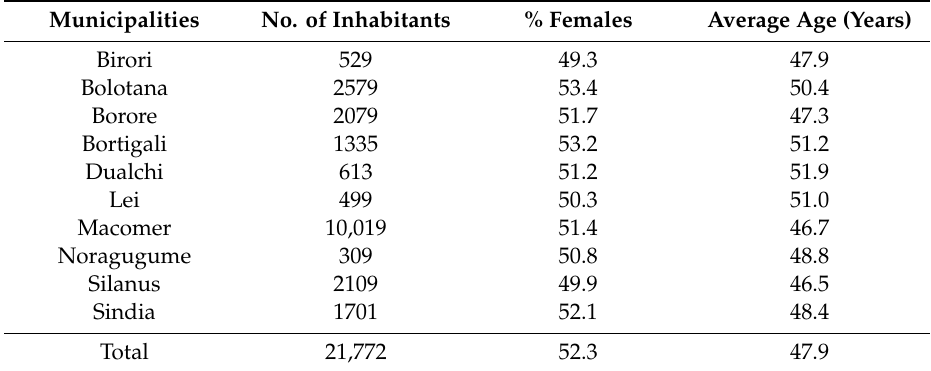
Table 2. Total inhabitants in Marghine (total) and in the individual municipalities as of 2018 [34].